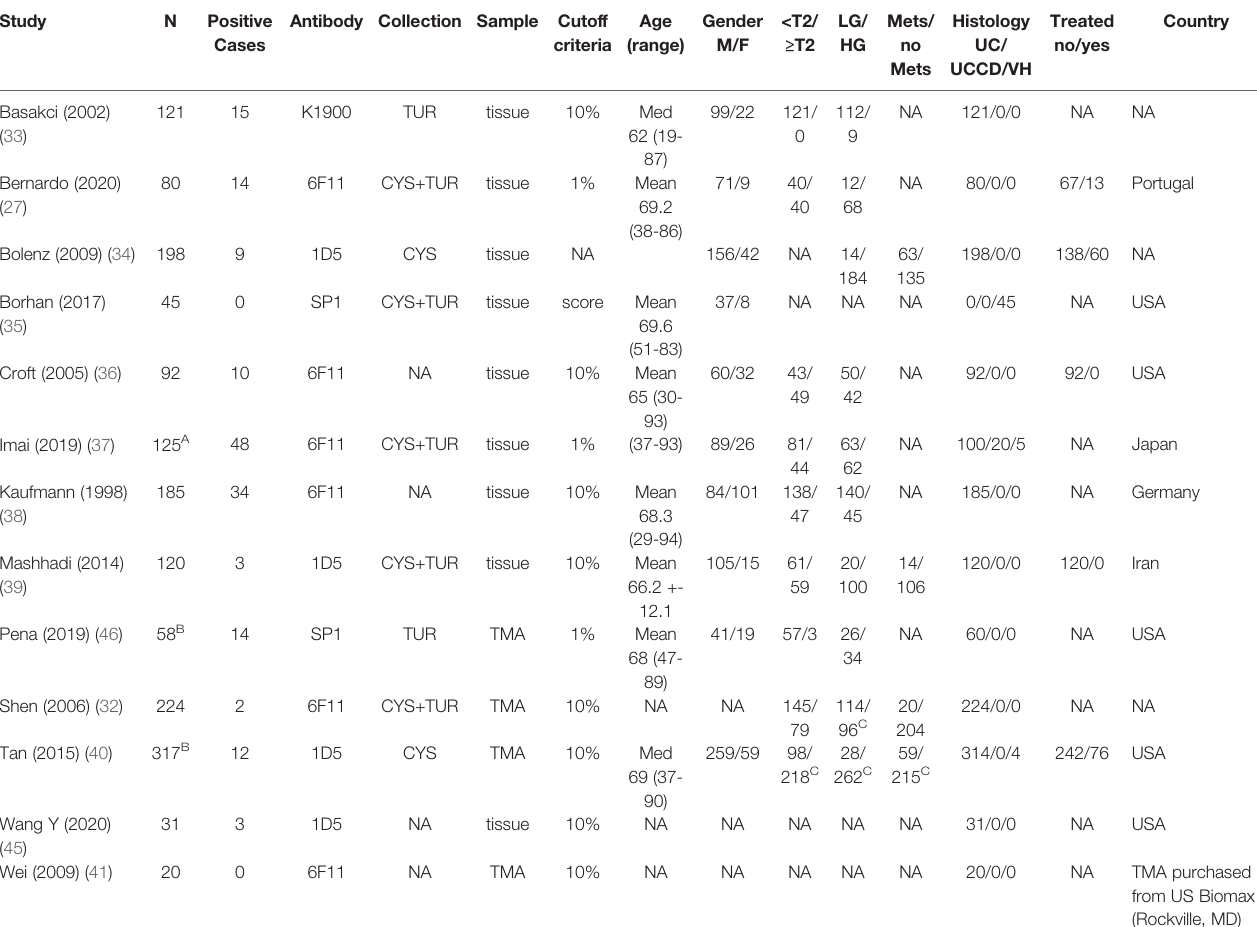
TABLE 1 | Characteristics of the studies included for meta-analysis of ER a expression in